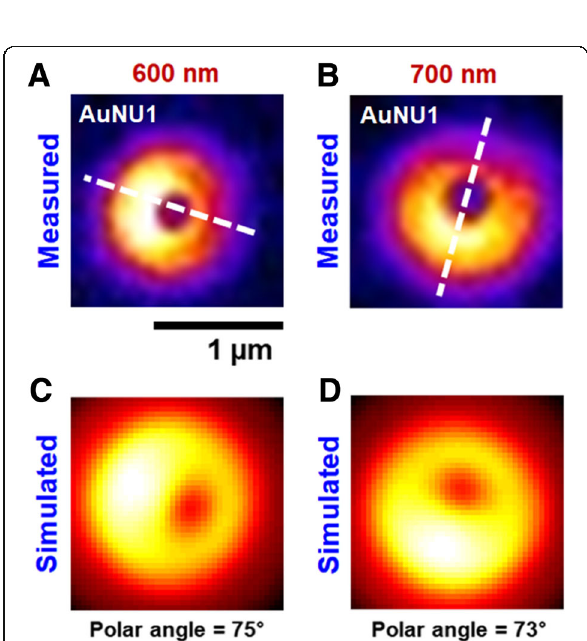
Fig. 4 a , c Measured and best-matched simulation patterns of single AuNU1 on a glass slide at 600 nm. b , d Measured and best-matched simulation patterns of single AuNU1 at 700 nm. The white-dotted line shows the single dipole orientation generated on the AuNU surface at the LSPR wavelength. The scale bar represents 1 μ